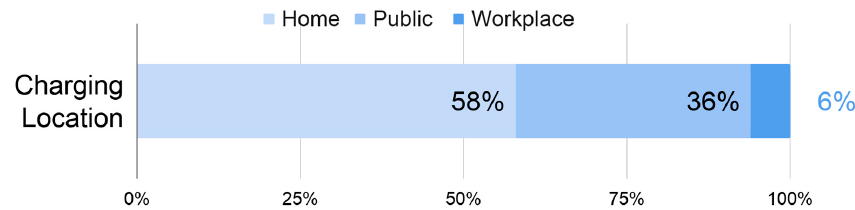
Figure 10. Mean distribution of charging location.